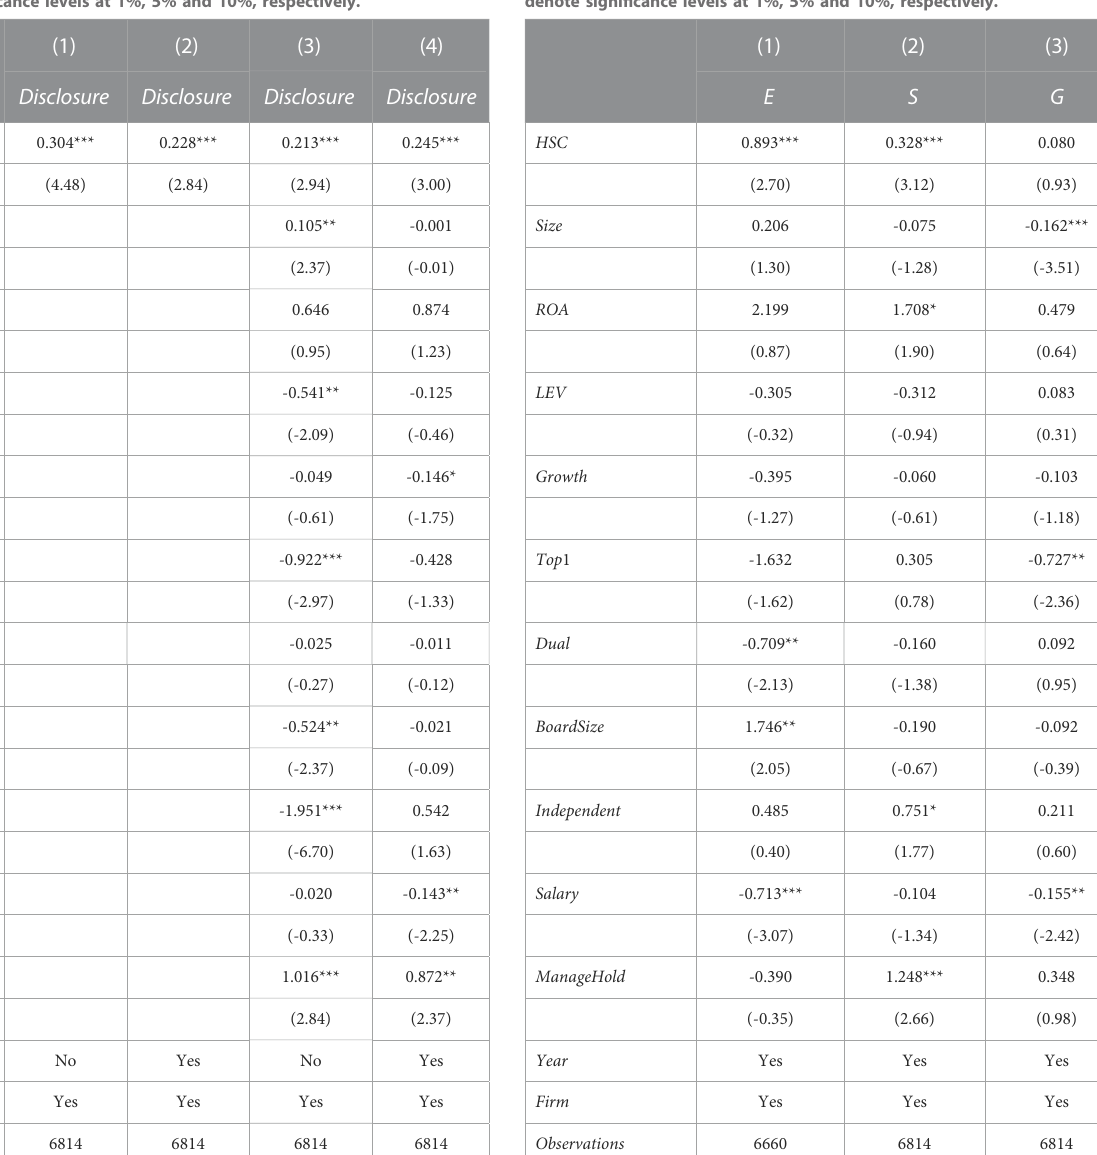
TABLE 4 The Effect of Capital Market Liberalization among Three ESG Pillars: This table shows the impact of capital market liberalization on the three ESG pillars disclosure. The dependent variable in columns 1 to 3 is the environmental score ( E ), the social score ( S ), and the governance score ( G ). The independent variable HSC is a dummy variable that takes the value one if the fi rm enters the list of mainland-HK Stock Connect, and zero otherwise. The control variables include fi rm size ( Size ), return on total assets ( ROA ), fi nancial leverage ( LEV ), operation income growth rate ( Growth ), ownership concentration ( Top 1), integration of two positions ( Dual ), board size ( BoardSize ), independent director ratio ( Independent ), top three executives ’ compensation ( Salary ), and management shareholding ratio ( ManageHold ). t -statistics are reported in parentheses below each estimate. ***, ** and